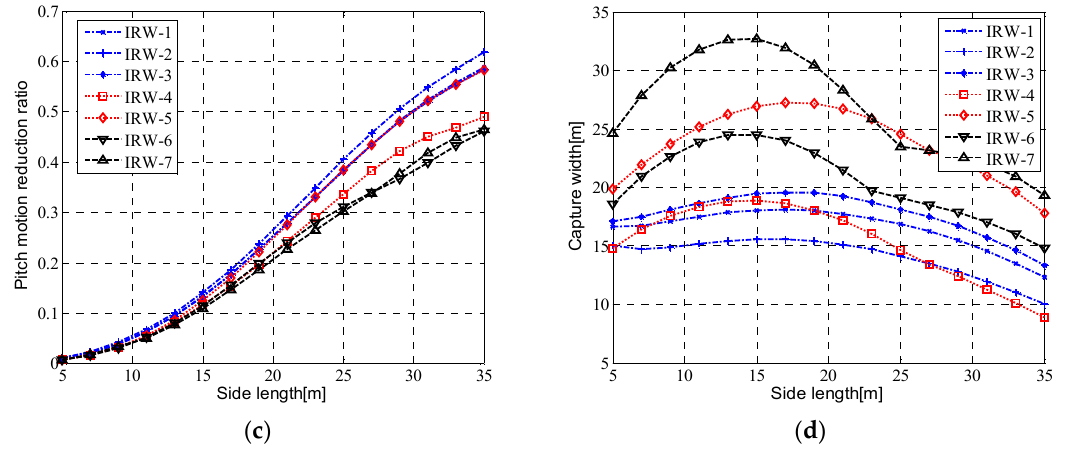
Figure 12. ( a ) The surge motion reduction ratio with optimal connection parameters with different sizes of the plate; ( b ) the heave motion reduction ratio with optimal connection parameters with different sizes of the plate; ( c ) the pitch motion reduction ratio with optimal connection parameters with different sizes of the plate; ( d ) the capture width reduction ratio with optimal connection parameters with different sizes of the plate.